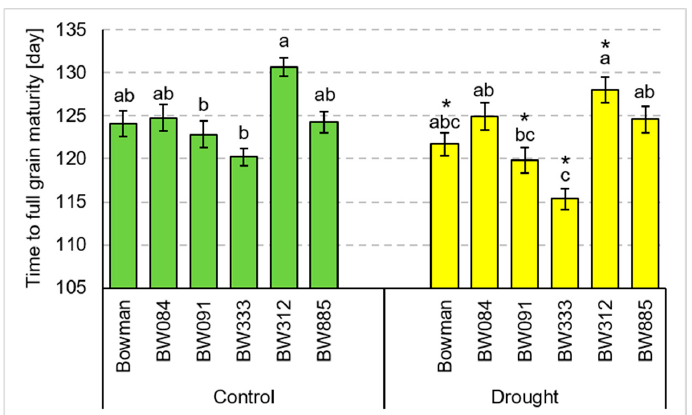
Figure 7. Time required for full grain maturity in the analyzed genotypes under the optimal watering (control) conditions and after the drought stress (the pot experiment). The mean values ± (SD) marked with the same letters (separately for the control and drought-stressed plants) are not significantly different, according to Duncan’s test ( p ≤ 0.05). Asterisks denote significant difference in comparison of values reported in each genotype between the control and drought conditions according to Student’s t -test. Details are given in the text.